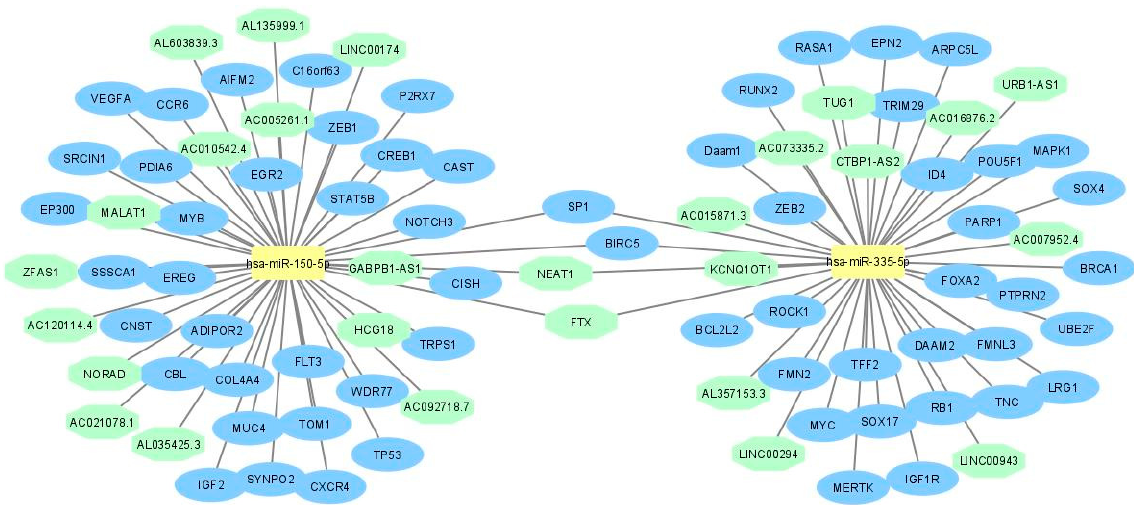
Figure 3. LncRNA–miRNA–mRNA networks related to hsa-miR-150-5p and hsa-miR-335-5p.